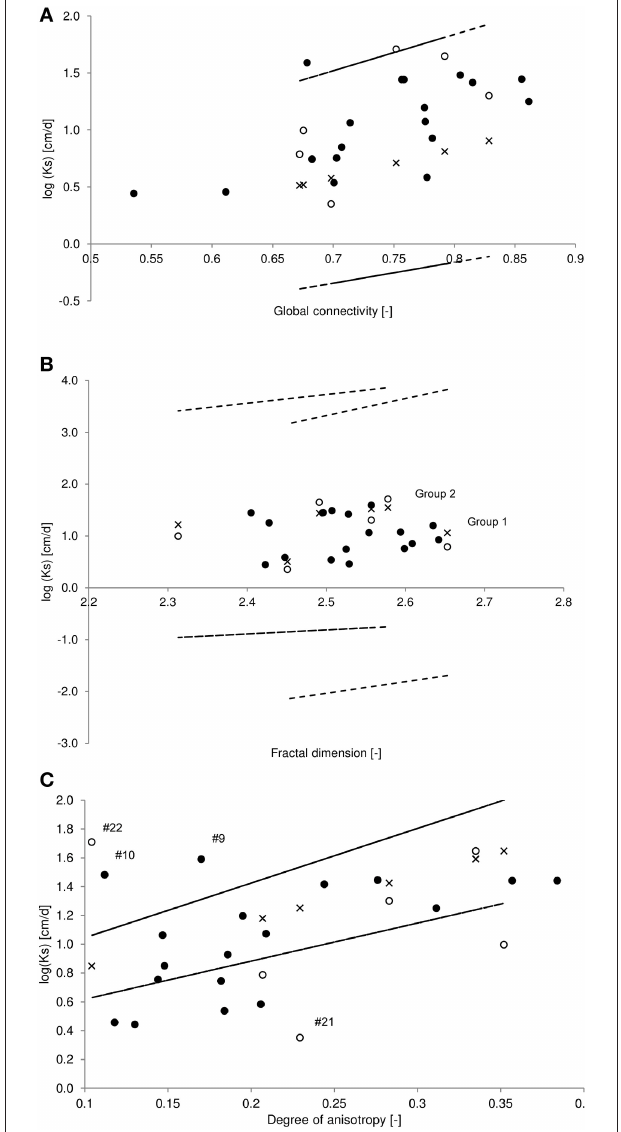
FIGURE 4 | Logarithmic saturated hydraulic conductivity (Ks) vs. (A) global connectivity calculated from the pore size distribution extracted from BoneJ, (B) the fractal dimension measured on X-ray µ CT images, and (C) the soil degree of anisotropy measured on X-ray µ CT images. Black and white circles represent the observations from the calibration and validation data sets, respectively. Crosses represent predicted validation data points and dotted lines represent the 25 and 75% regression model